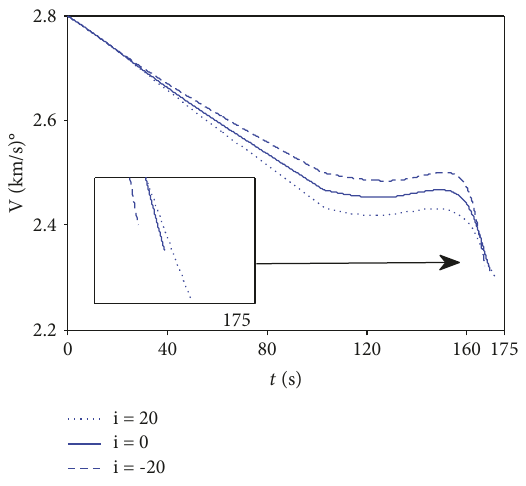
Figure 9: Di ff erent velocity curves with i